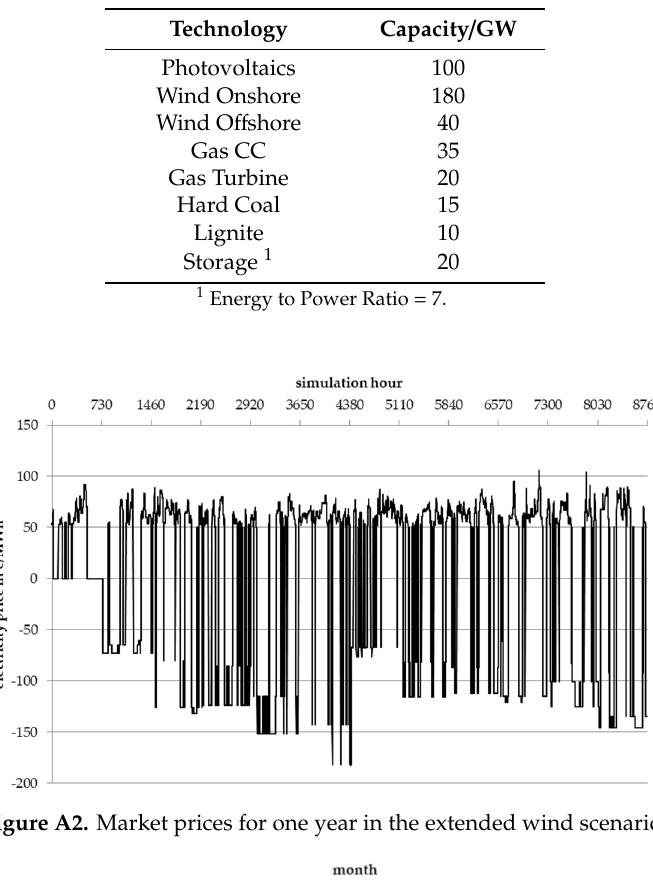
Table A1. Scenario parameters for the technologies in the extended scenario.